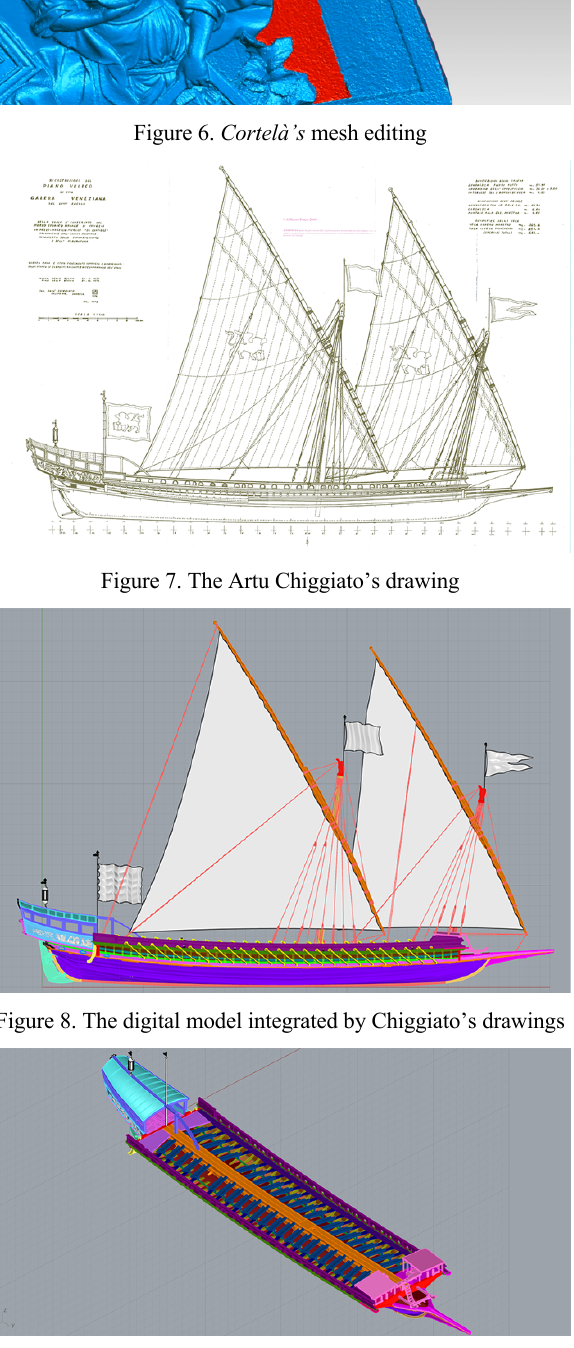
Figure 9. View of the digital model with the classification of